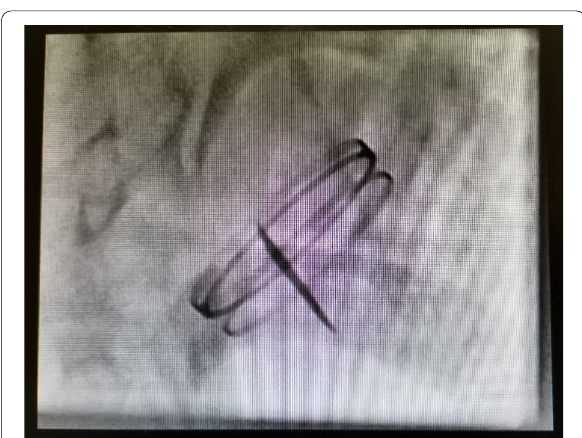
Fig. 2 Fluoroscopy valve screen showing a single leaflet of the